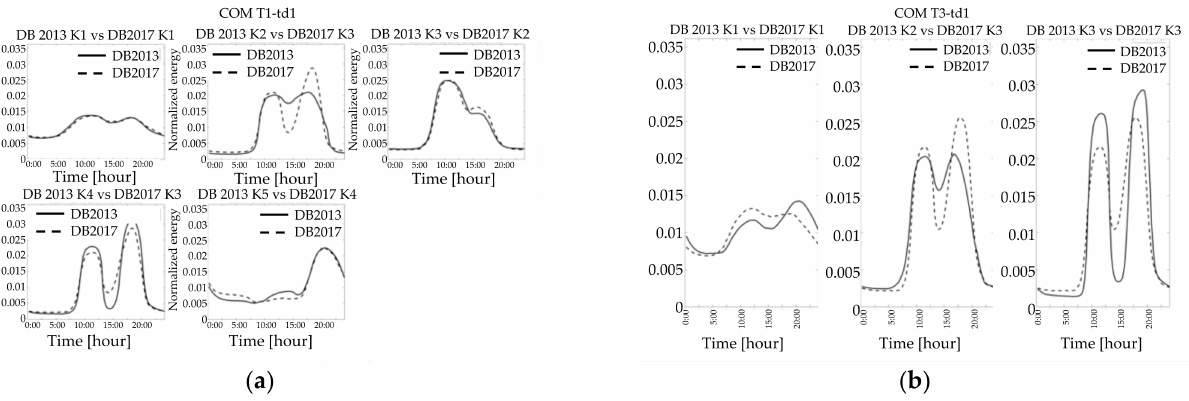
Figure 10. Commercial (COM) end-users, comparison between normalized centroids of the two databases (DB2013 vs. DB2017): ( a ) winter workdays, ( b ) summer